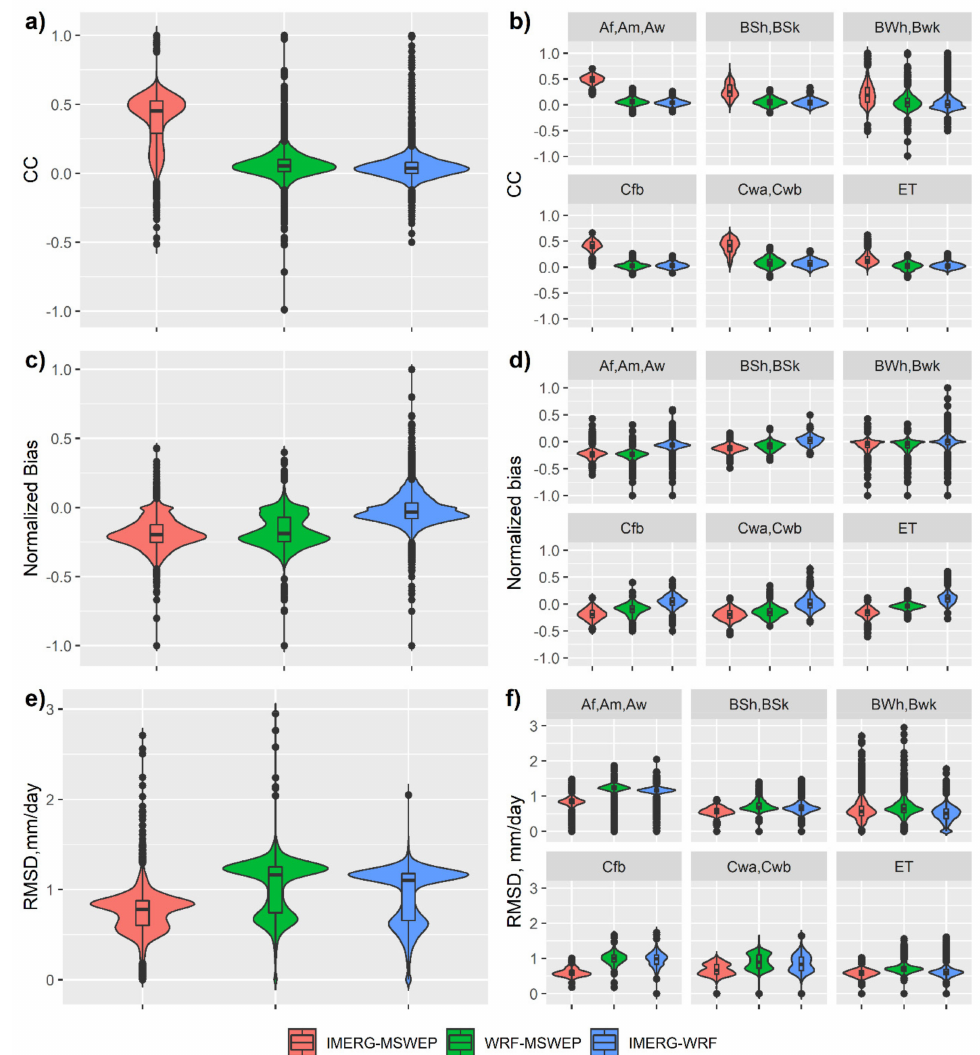
Figure 7. The violin plot of cross-examination between GPM IMERG, MSWEP, and WRF simulations in six major climate zones, where ( a , c , e ) are the aggregated statistic for CC, NB, and RMSE, and ( b , d , f ) are the statistic at each climate